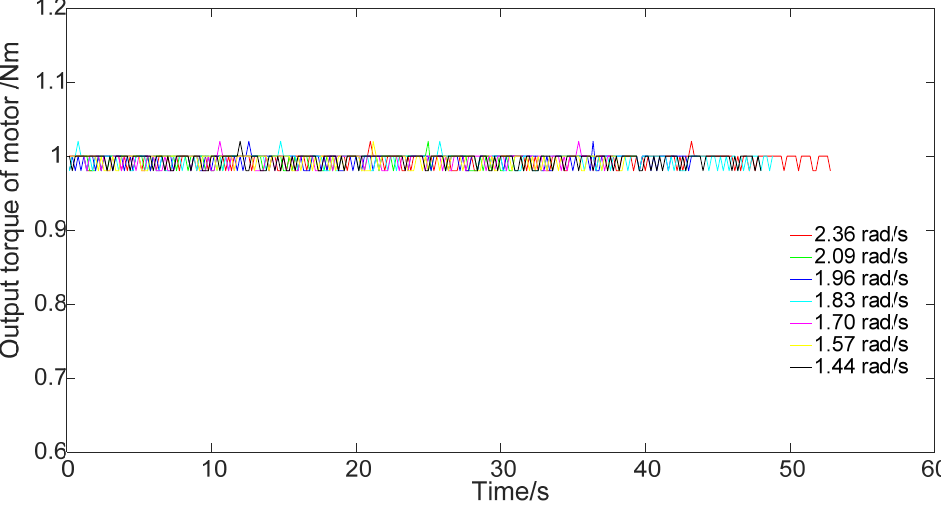
Figure 5. Output torque of motor without harmonic